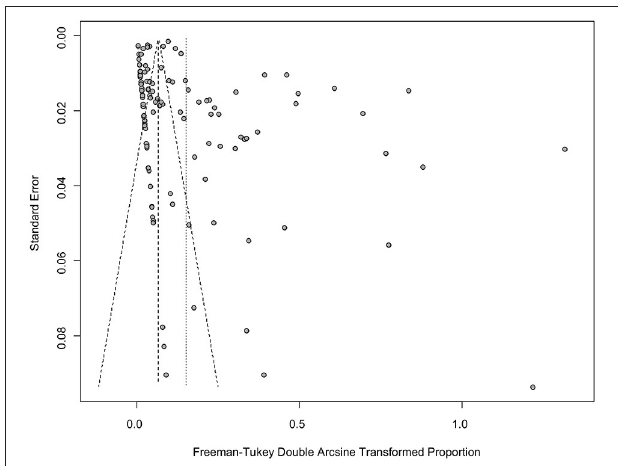
FIGURE 3 | Funnel plot with pseudo 95% confidence intervals for the publication bias test.